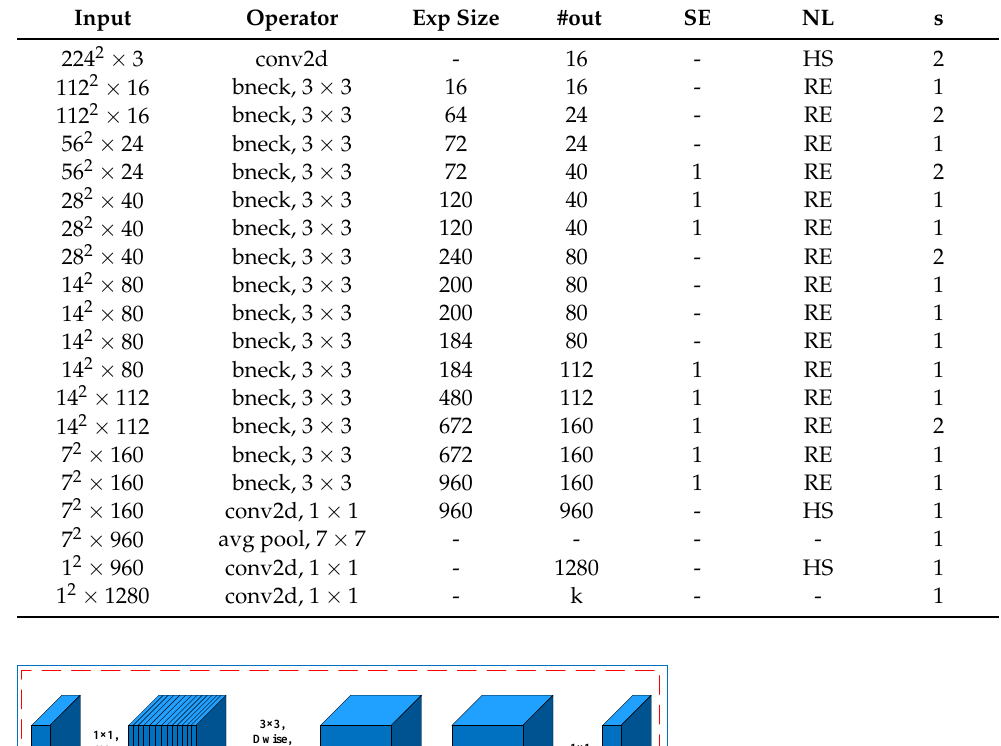
Table 1. Specifications for MobileNetV3Large.